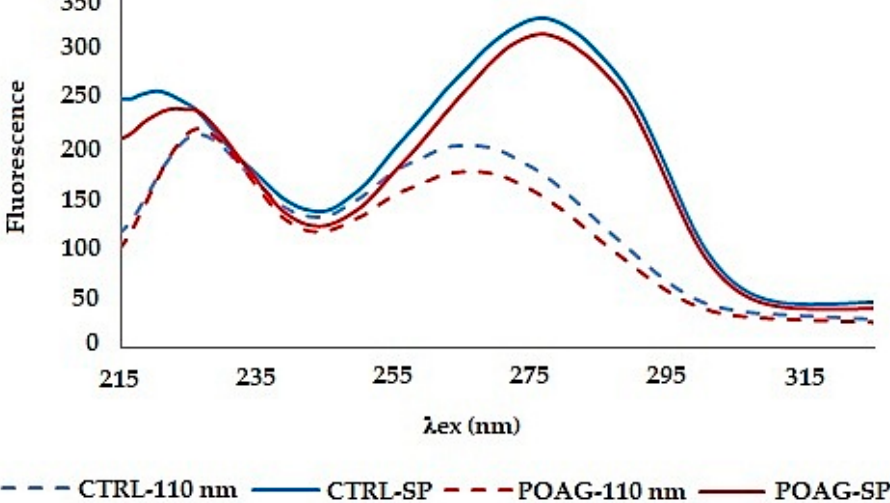
Figure 3. Comparison of SFS, ∆ λ = 110 nm and synchronous profile (SP) of selected groups. The average spectrum of tear sample’s group is shown: CTRL—control, POAG—glaucoma [12].